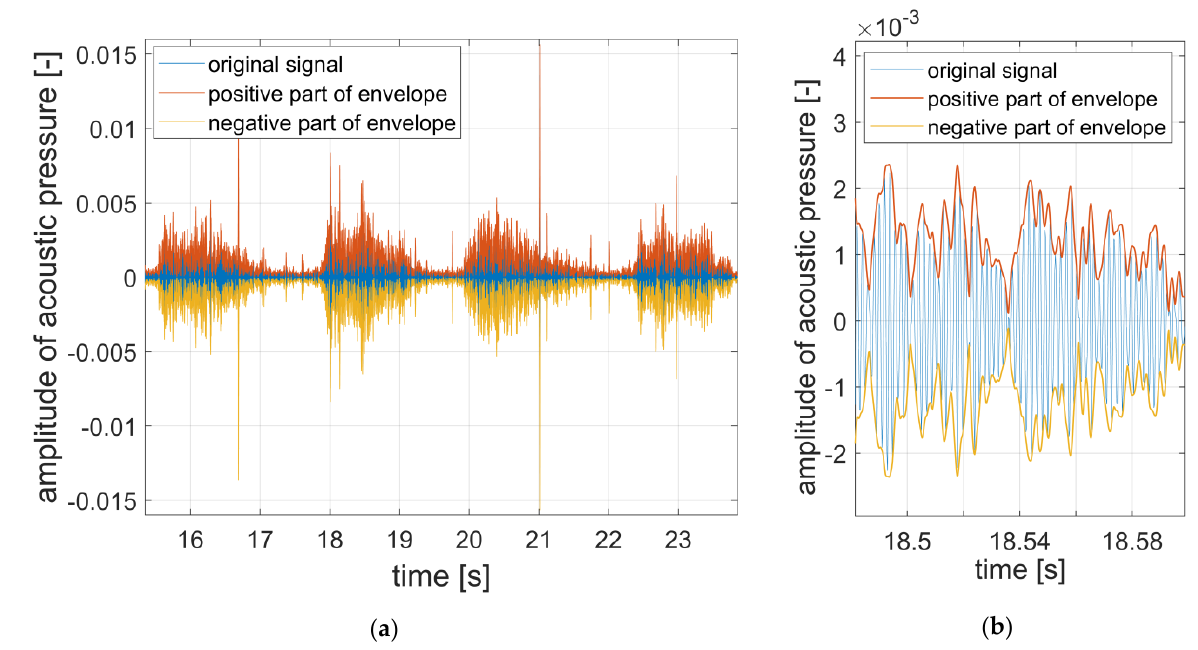
Figure 4. ( a ) Original filtered signal with positive and negative parts of the envelope; ( b ) detail.